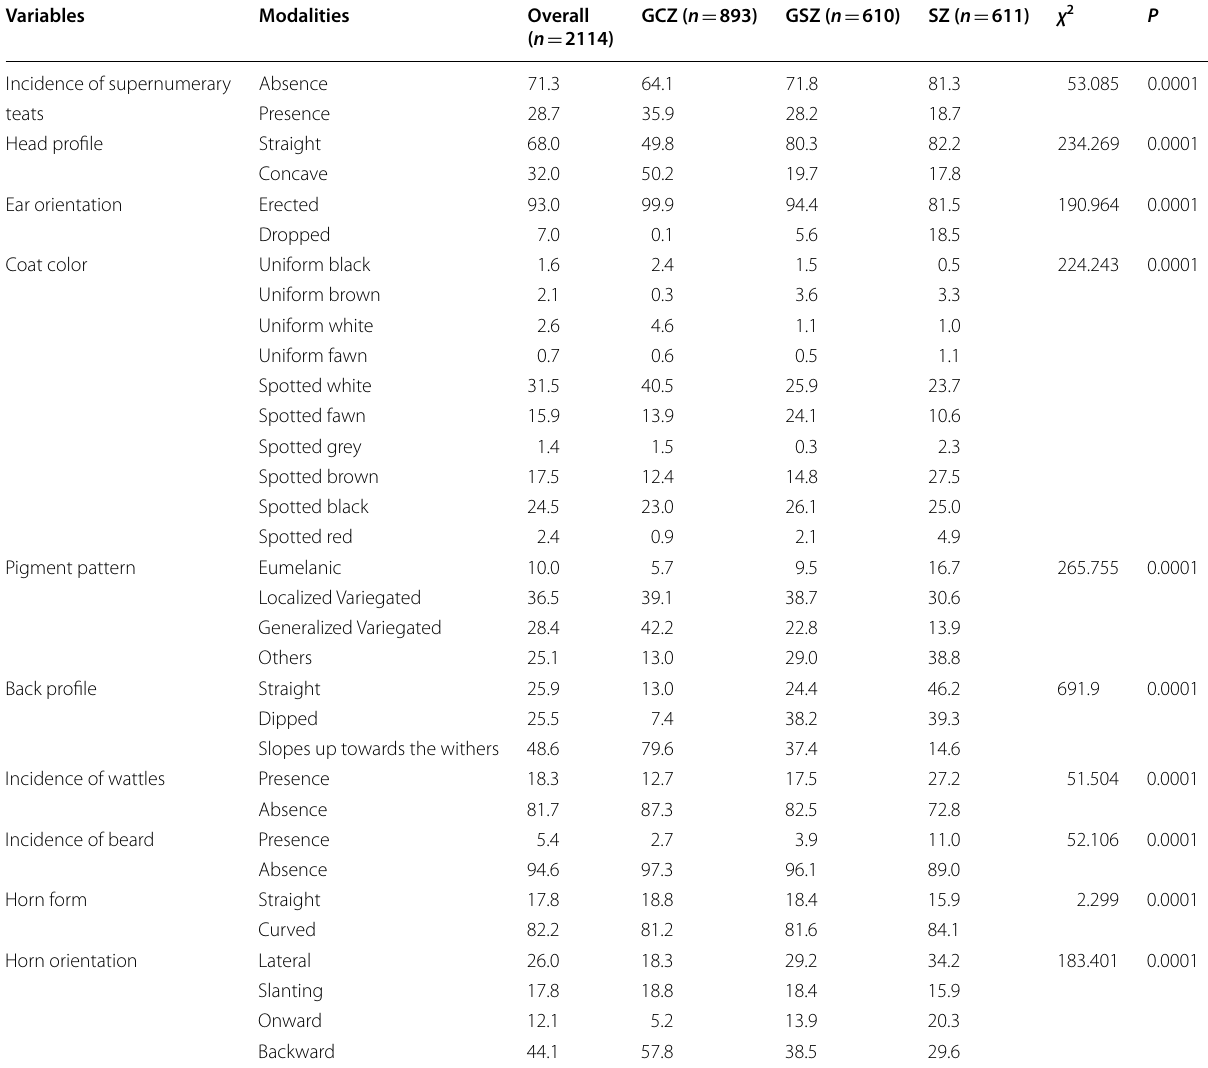
Table 3 Frequency (%) of qualitative traits of goat subpopulations of three vegetation zones of